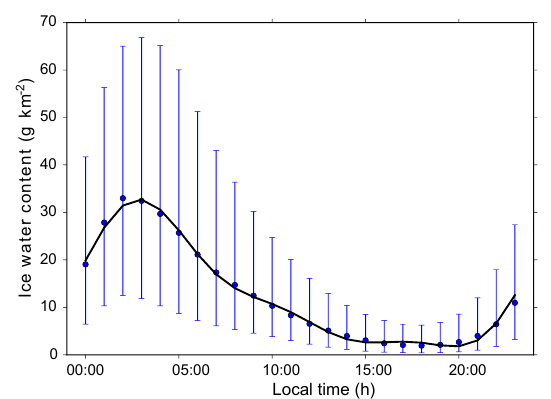
Figure 5. Hourly median values of IWC from 2007–2013 (July) for 67–71 ◦ N and IWC threshold of 10gkm − 2 as a function of local time. The vertical bars represent the lower and upper quar- tile of the data. The black curve is a harmonic fit to the data with periods of 24, 12, and 8h. Data from AIM satellite instru- ments including uncertainties for the same time range: SOFIE V1.3 (red – from http://sofie.gats-inc.com/sofie/index.php, last access: 25 November 2016) and CIPS Level 3c-v4.20 (green – from http: //lasp.colorado.edu/aim/download-data-pmc.php, last access: 5 De- cember 2016) for ascending and descending nodes.